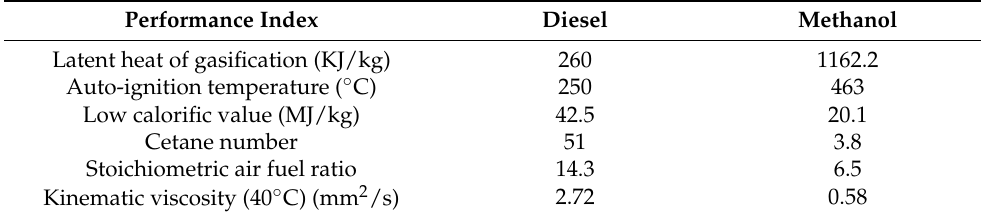
Table 2. Main physical and chemical properties of diesel and